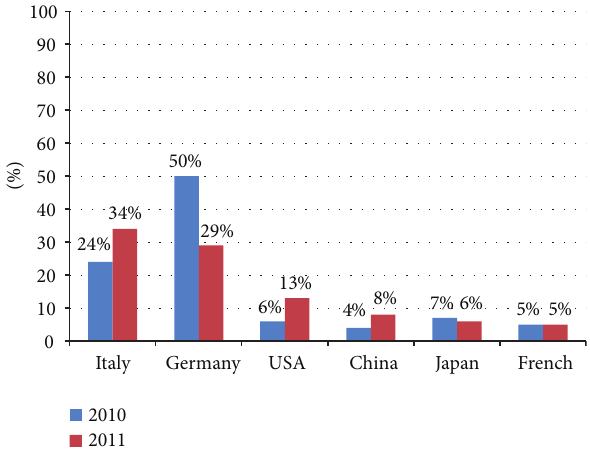
Figure 5: 2010-2011 global solar photovoltaic device market. Source: PIDA (2012) [1].